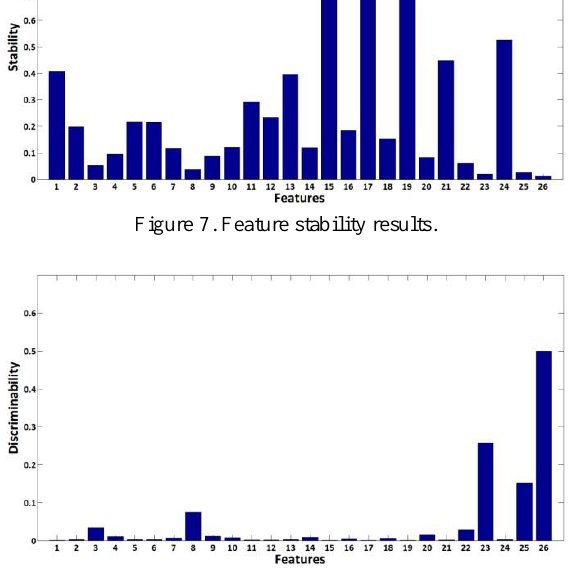
Figure 8. Feature discriminability